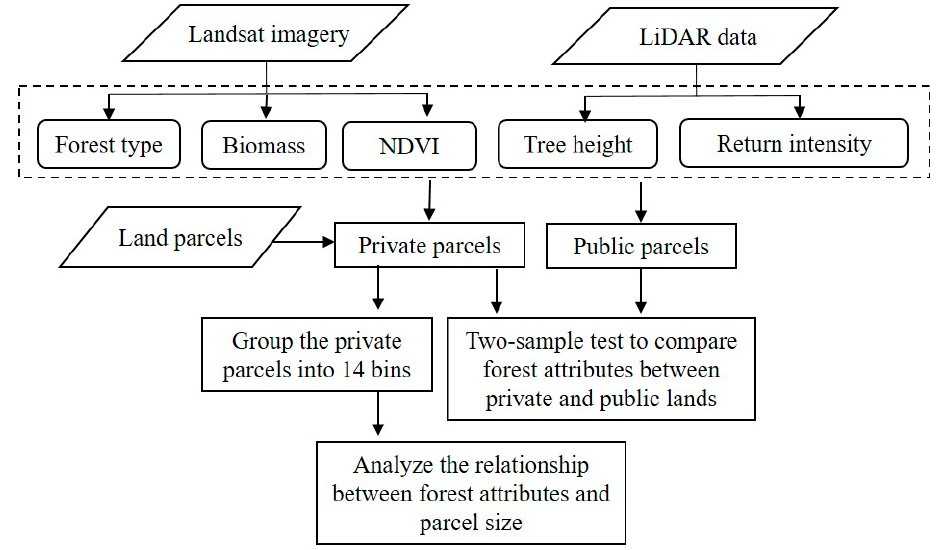
Figure 2. Flowchart of using Landsat imagery and LiDAR data to investigate the impact of land parcelization on forest development.